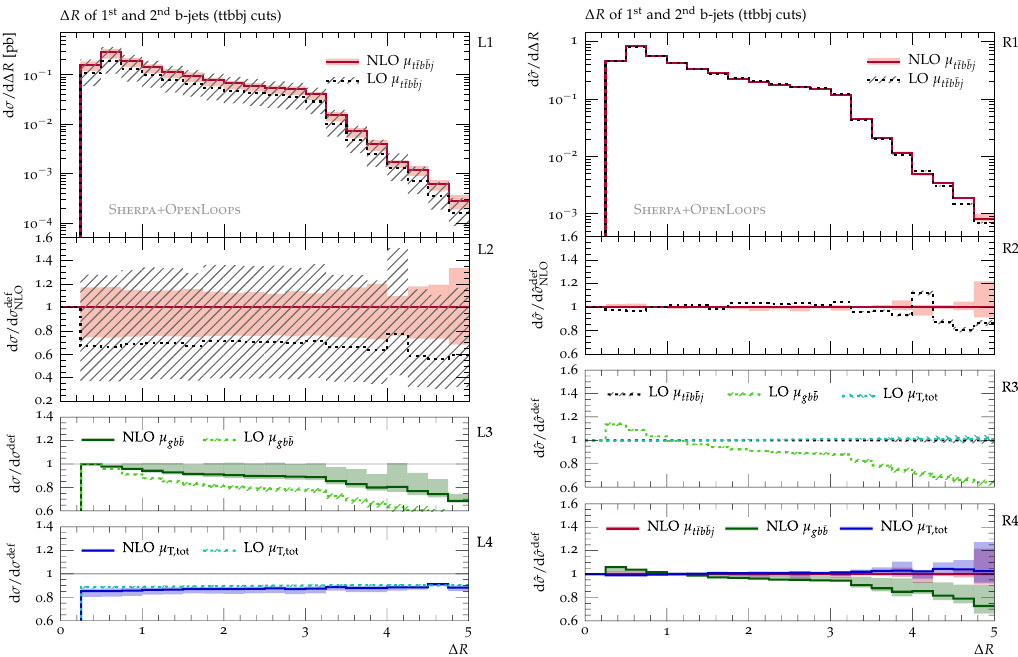
Figure 15. (cid:1) R between the two b -jets. Same setup and plots as in (cid:12)gure 8.